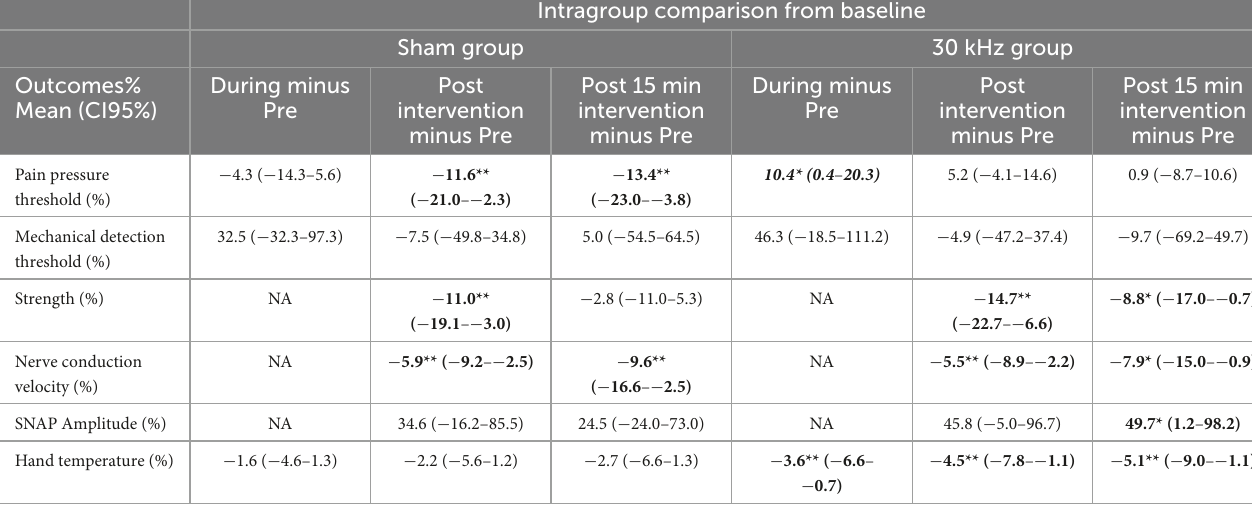
Intragroup comparison from